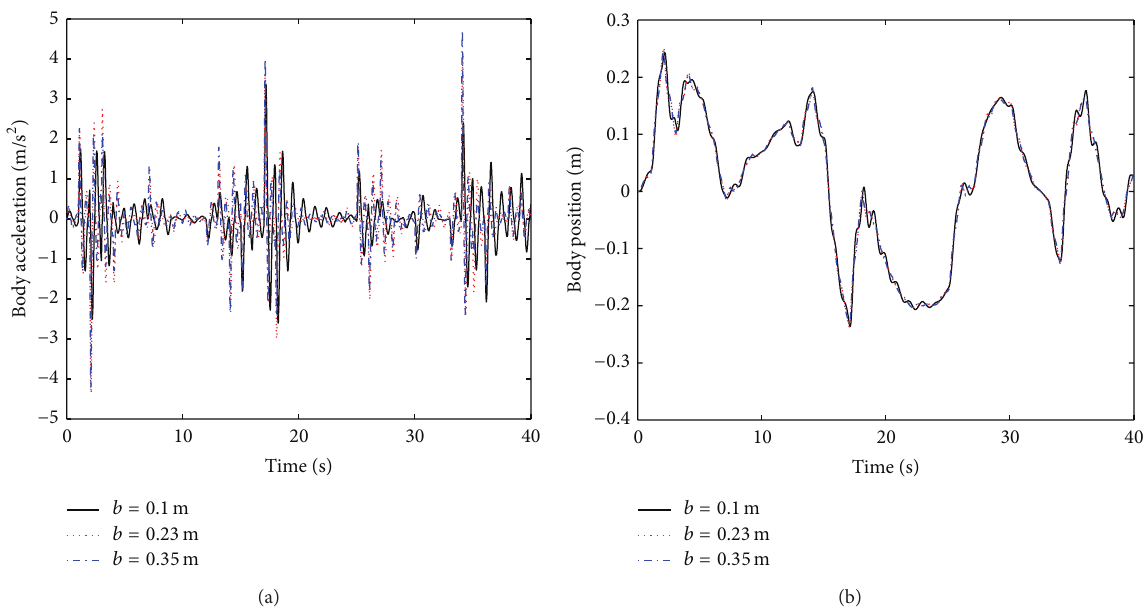
Figure 7: Acceleration and displacement of the sprung mass with different wheel widths.